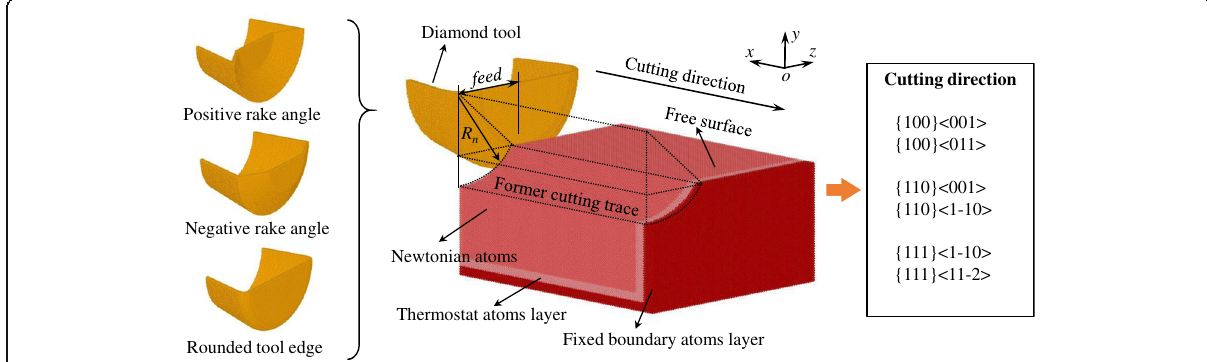
Fig. 1 Schematic description of nano cutting model with three kinds of cutting tools and six cutting directions